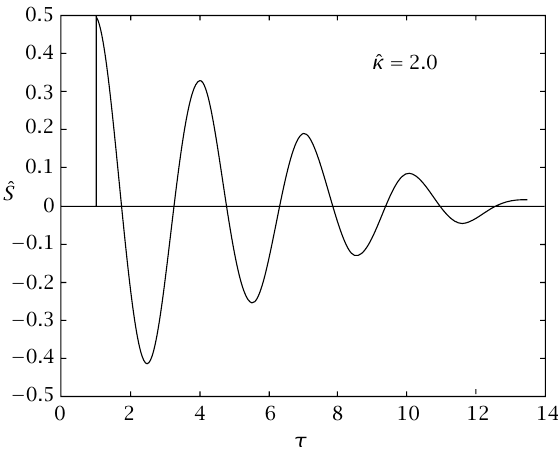
Figure 2.2 . The stress ˆ S as a function of dimensionless time τ ( 0 ≤ τ ≤ 14 ) at the cross-section ξ = 1 and for ˆ κ = 2 . 0